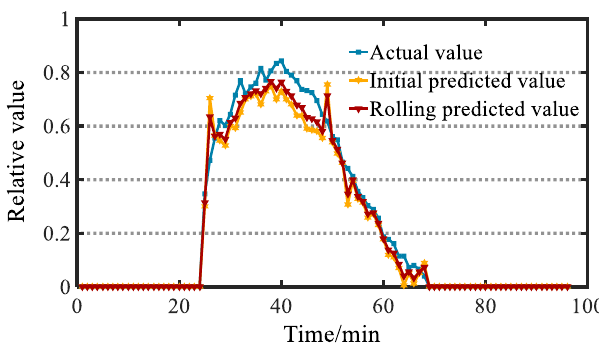
Figure 5. Comparison of PV prediction results.